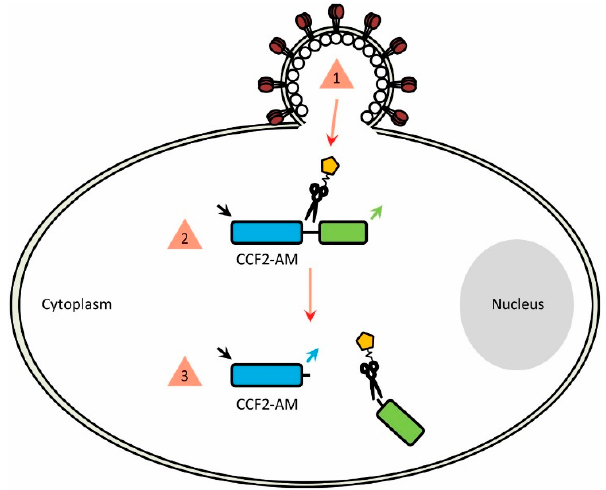
Figure 3. (1) Fusion between the virus particle and target cell (either at the cell membrane or from within endosomes) liberates the encapsulated β -lactamase (2) The enzyme is then able to access the cytoplasmic CCF2-AM FRET substrate (3) CCF2-AM cleavage occurs and the fluorescence profile is altered, indicating fusion has occurred.